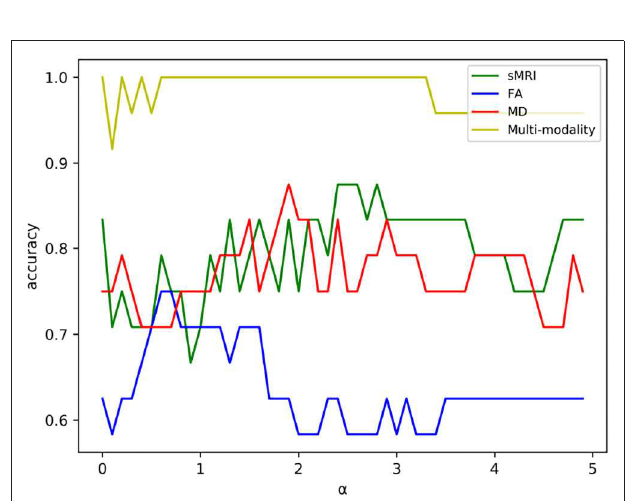
FIGURE 4 | The variation curve of classification accuracy changing with α . Some values of α will arouse the problem of overfitting in a classification task, and such values were discarded in